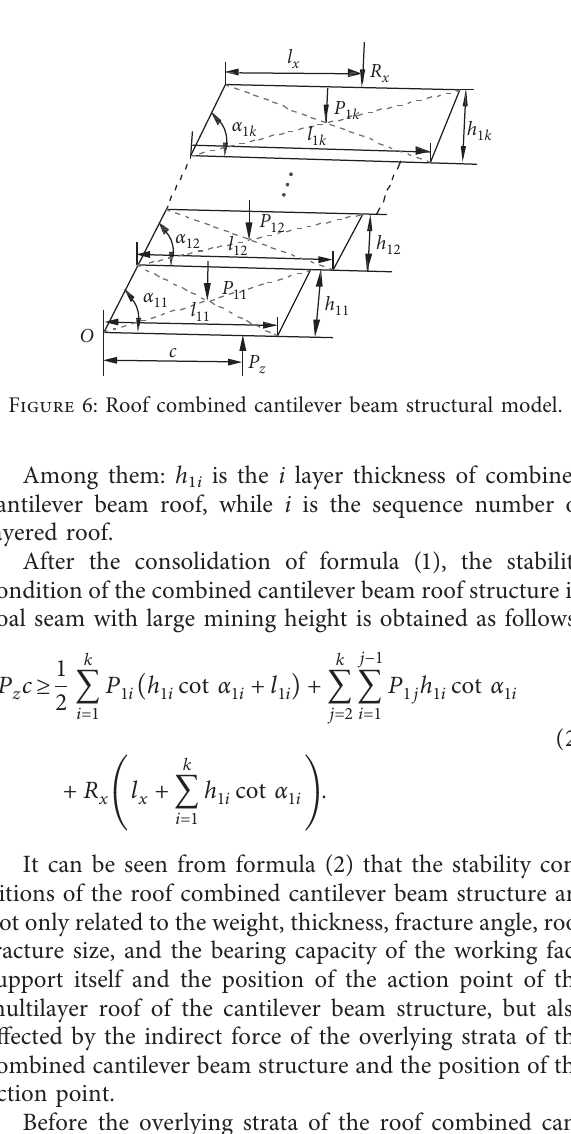
Figure 5: The relationship between support surrounding rock of fully mechanized working face with large mining height.